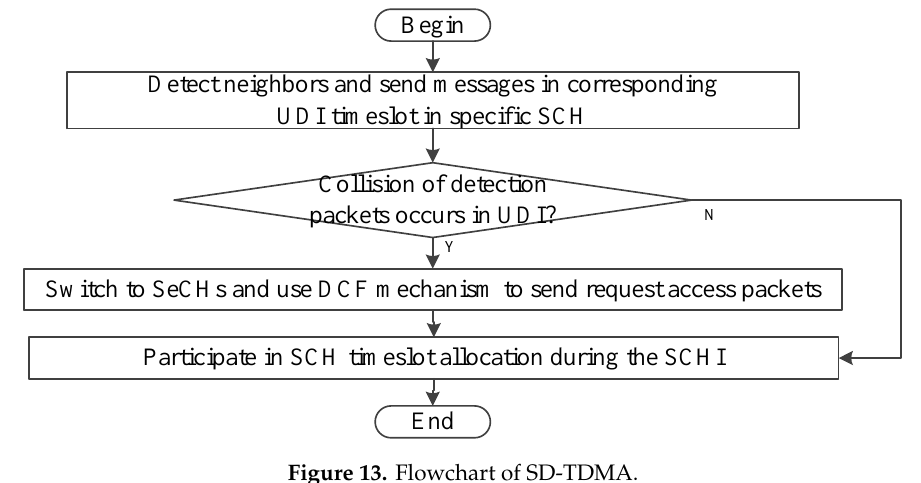
Figure 13. Flowchart of SD-TDMA.